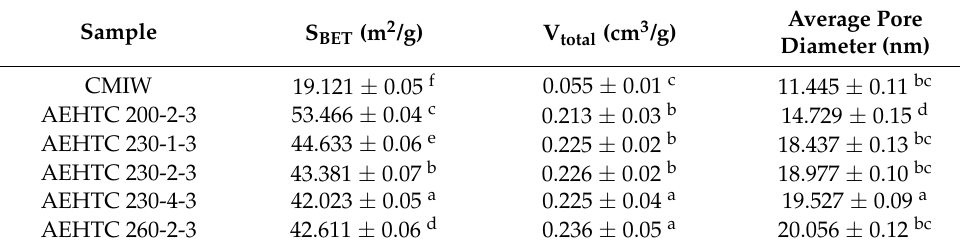
Table 1. Porous structure properties of CMIW and AE-CMIW hydrochar.